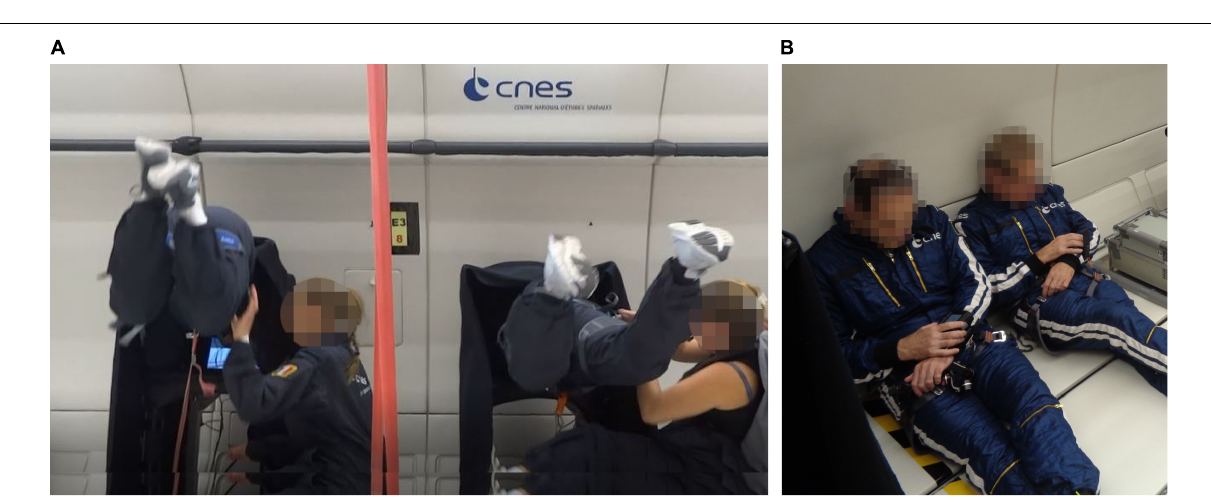
FIGURE 2 | Experimental set-up. (A) Participants performing the Continuous Performance Task (CPT) in a controlled free-floating position. (B) Participants performing the psychomotor vigilance test (PVT) using a diving computer that was attached to participants’ wrist. During both tasks, two participants were tested at the same